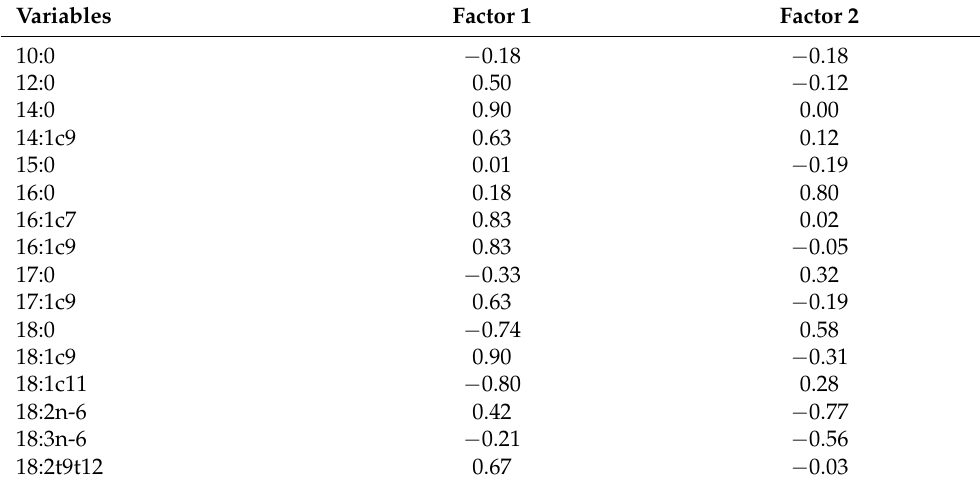
Table 10. Loadings for the first two principal components in the breast